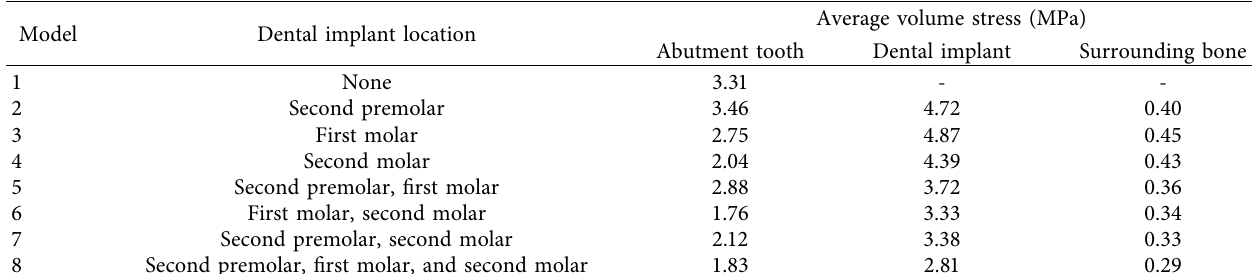
Table 3: Average volume stress of eight models.